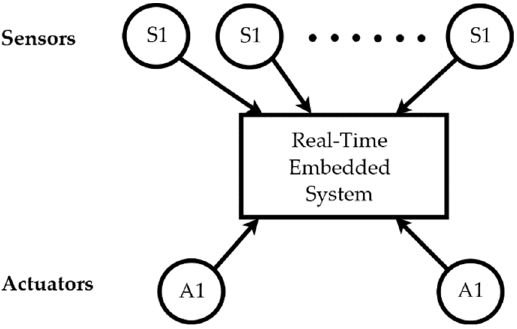
Figure 1. A model of sensors and actuators in an embedded system [21]. Hard real-time embedded systems ( RTESs ) refer to those embedded systems which require real-time behavior with for a missed deadline [22]. The software part of an RTS is an application that runs either in stand-alone mode (bare metal) or scheduled as a task on a real-time operating system (RTOS). The hardware part includes one or more central processing units (CPU), memory elements, and input/output (I/O) devices with interrupt mechanisms to provide deterministic bounded responses to external